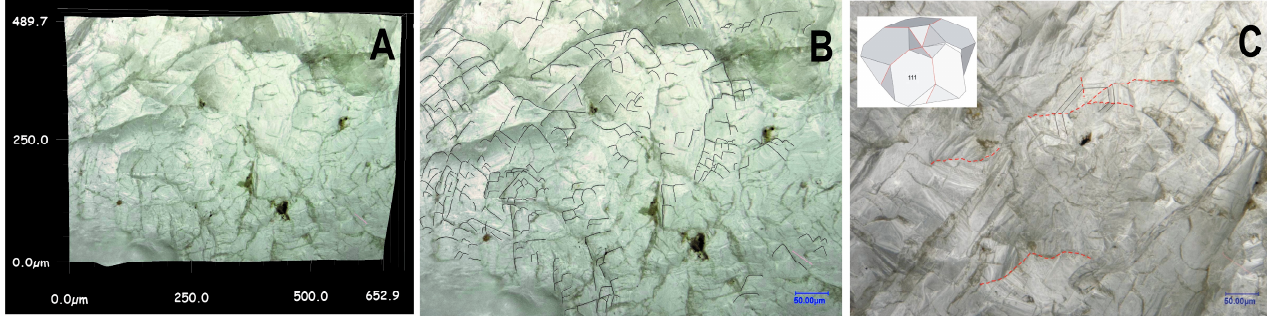
Figure 3. 3D optical microscopy images of the “large” ballas. ( A , B )—quasi-3D representation of the surface. Lines highlight trigonal motif of the surface features. ( C )—rare cyclic twin, the inset shows its simpli fi ed scheme.